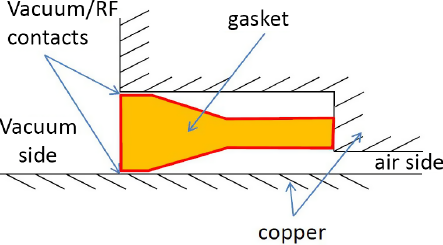
FIG. 7. Sketch of the transverse profile of the special vacuum/rf gasket used for gun clamping.